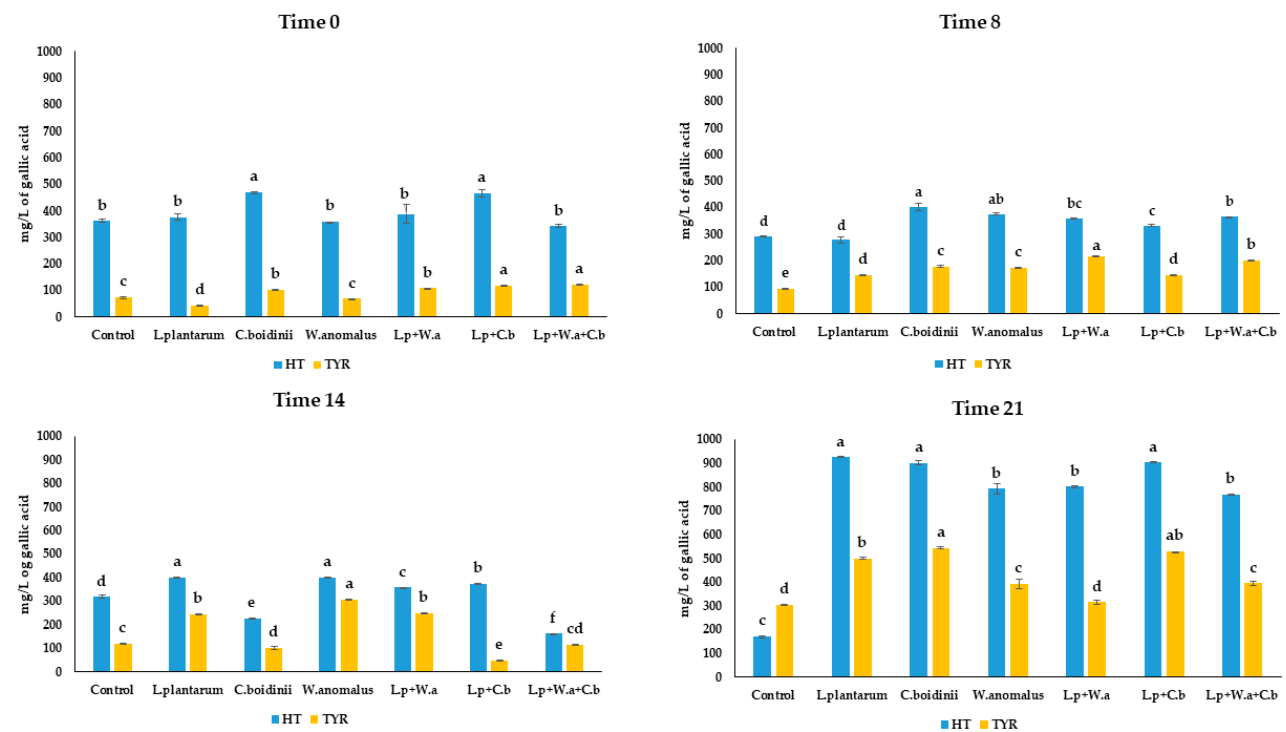
Figure 2. Concentration of HT and TYR during fermentation in microfiltered OMWW differently inoculated. Different letters indicate statistical differences within the columns for the same compound (significance at p ≤ 0.01).